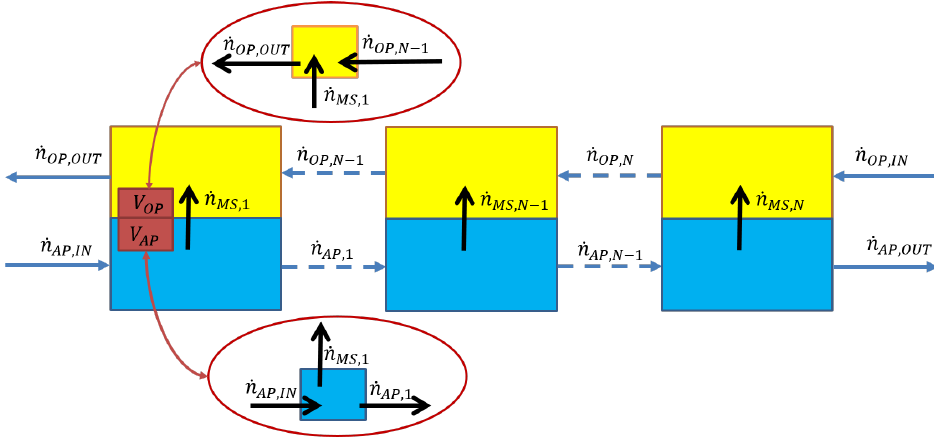
Figure 2. Schematic model for the counter-current multistage extraction with N extraction stages (OP—organic phase, AP—aqueous phase, MS—mass